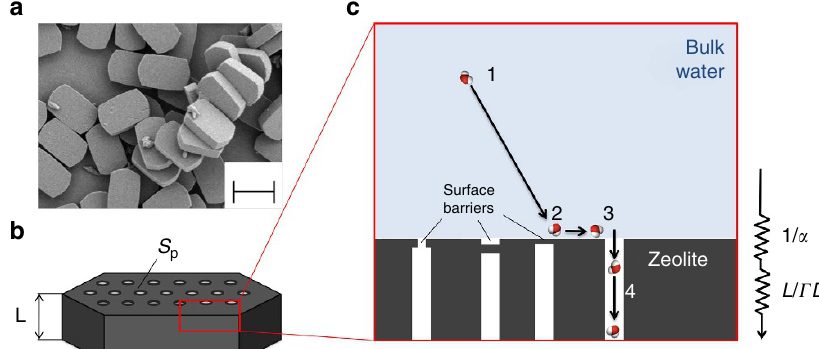
Figure 3 | Diffusion resistances for water at the nanoscale. ( a ) Scanning electron microscopy of the considered MFI zeolites (scale bar, 3 m m). ( b ) Representation of a zeolite specimen: water molecules can intrude the nanopores through the surface S p , whereas V ¼ S p L is the volume of the specimen. ( c ) Water transport through microporous materials is influenced by a series of nanoscale mass transport phenomena, namely: (1) bulk diffusion; (2) sticking probability to the solid surface; (3) resistance to micropore intrusion due to surface barriers (1/ a ); (4) diffusion resistance in the micropore network ( L /( G D